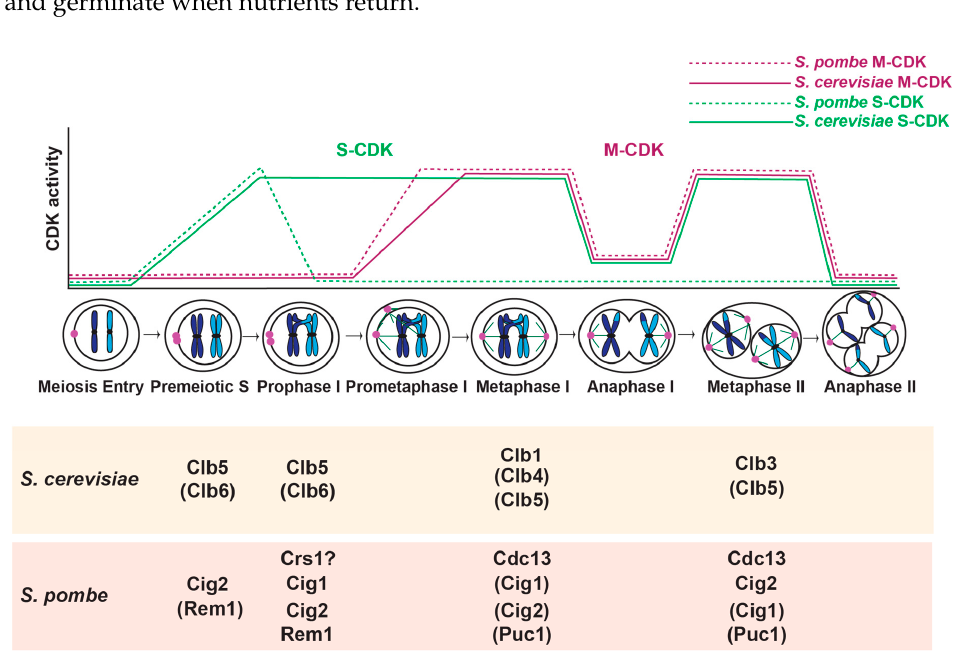
Figure 1. Oscillation of cyclin-dependent kinase (CDK) activity and cyclins present in each stage of meiosis. In budding yeast, S phase CDK (S-CDK) activity peaks during premeiotic S phase and